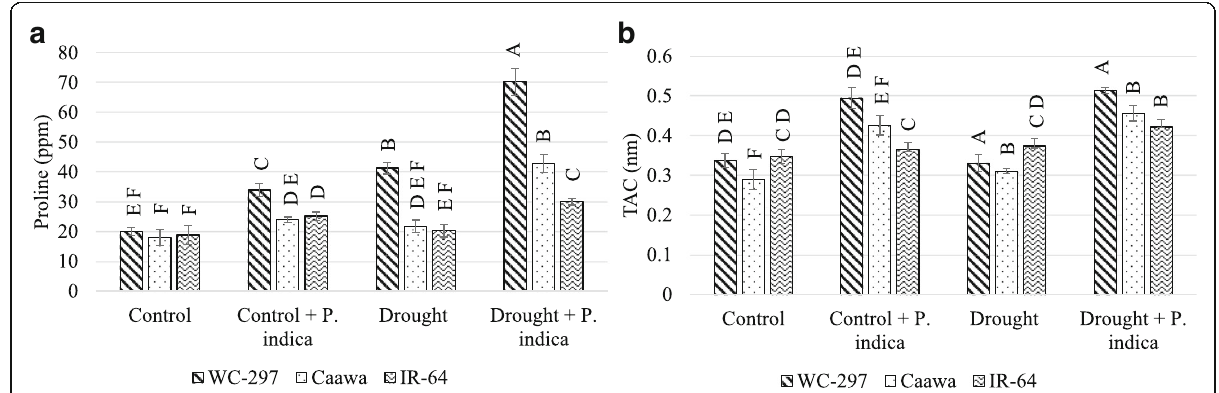
Fig. 5 Change in the concentration of proline and TAC. The inoculation with P. indica increased the concentration of proline and total antioxidant capacity (TAC) in both the absence and presence of osmotic stress. a Increase in proline concentration. b Increase in TAC. Alphabetic on the top of each bar are showing the LSD 0.05